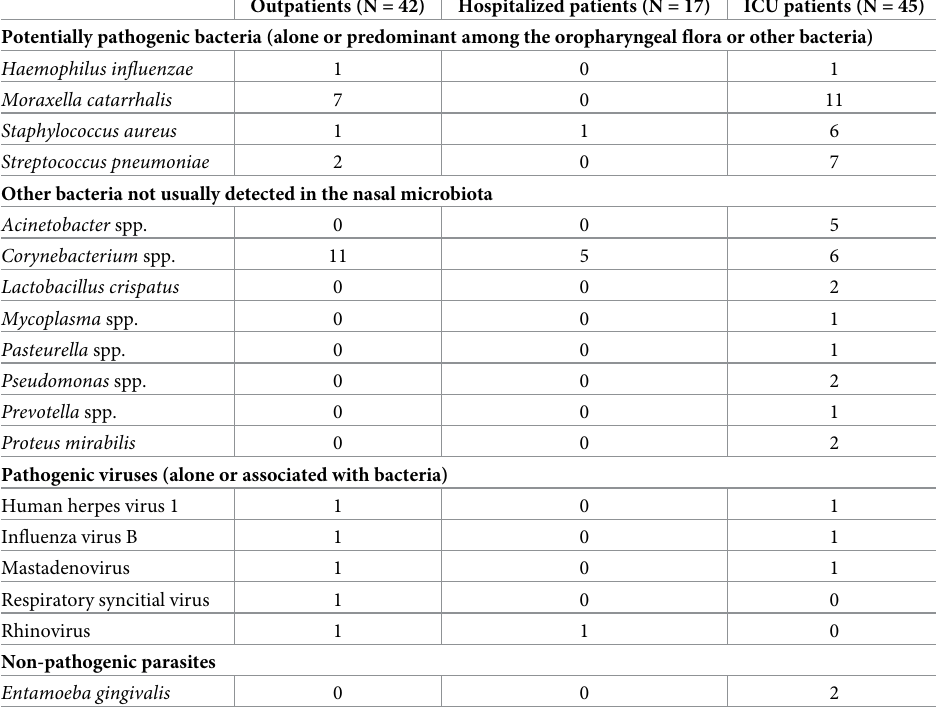
Table 2. Bacterial, viral, fungal and parasite coinfections in nasopharyngeal swabs from the 104 patients, classi- fied according to the severity of COVID-19 and their pathogenic